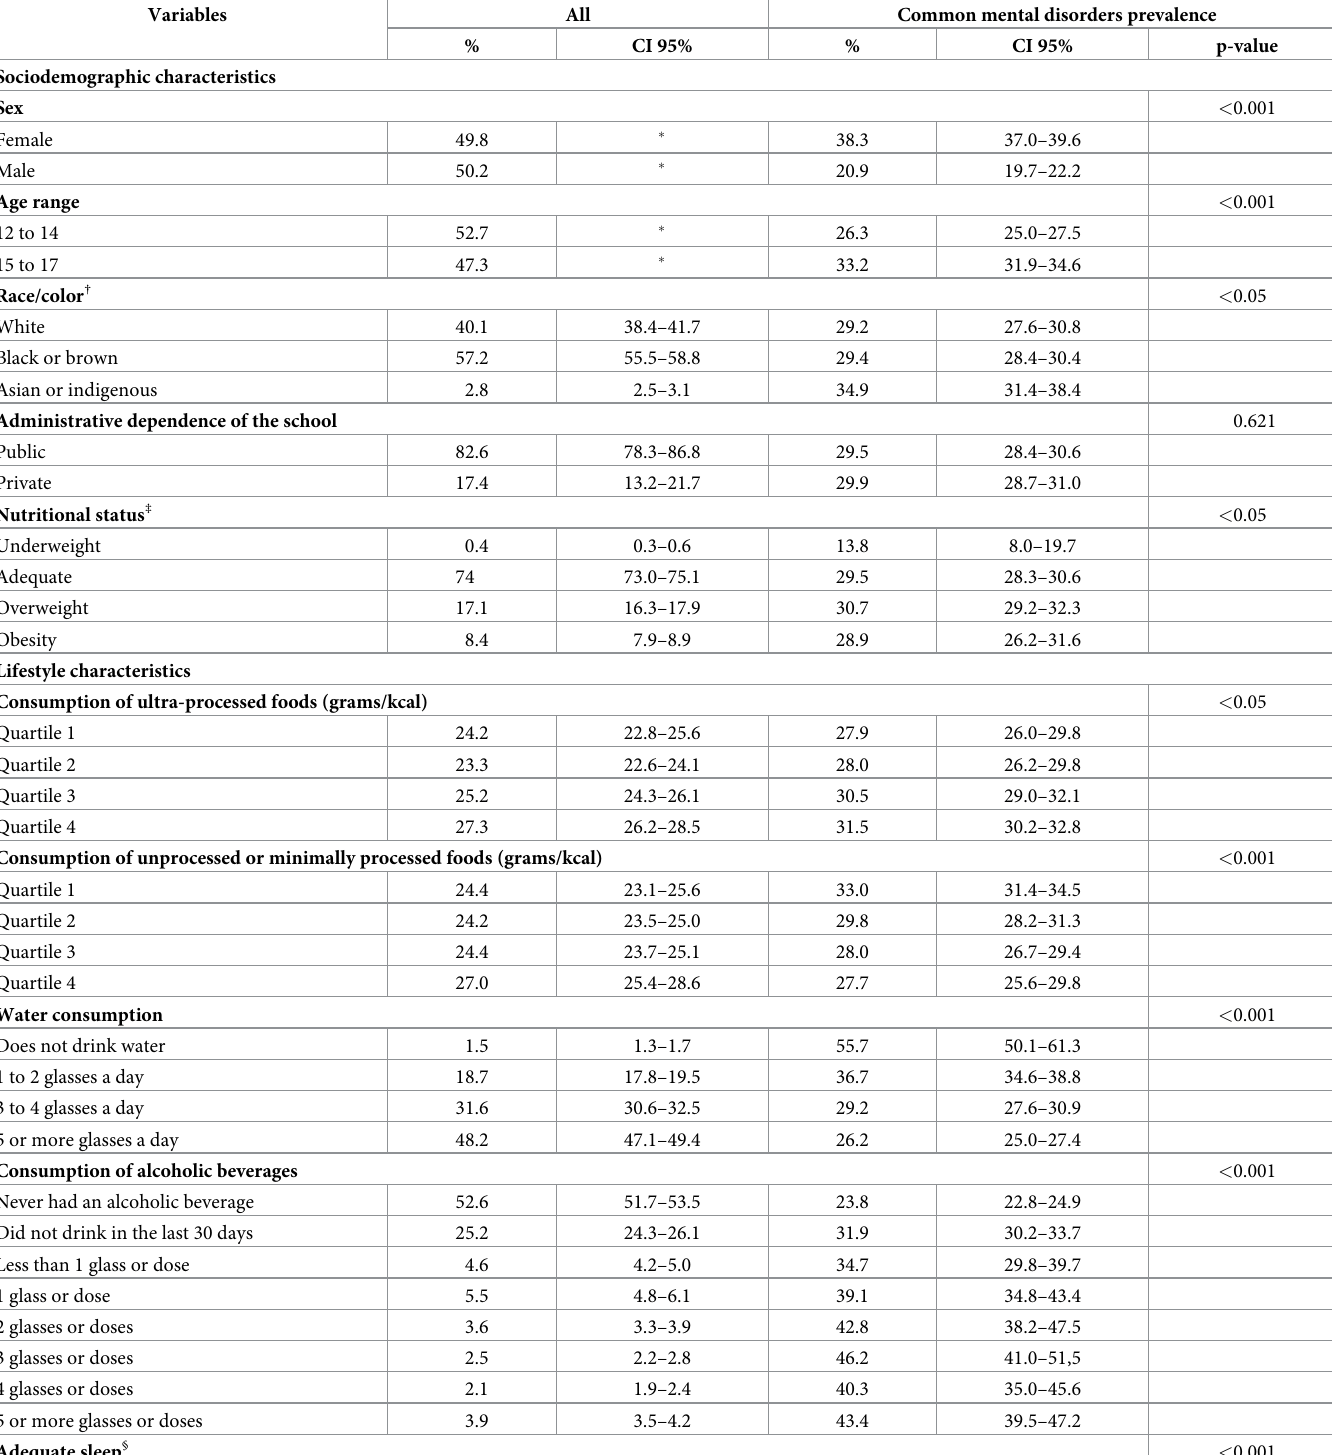
Table 1. Distribution of adolescents in relation to common mental disorders, sociodemographic characteristics, nutritional status, and lifestyle characteristics. Study of Cardiovascular Risks in Adolescents (ERICA), Brazil, 2013–2014.